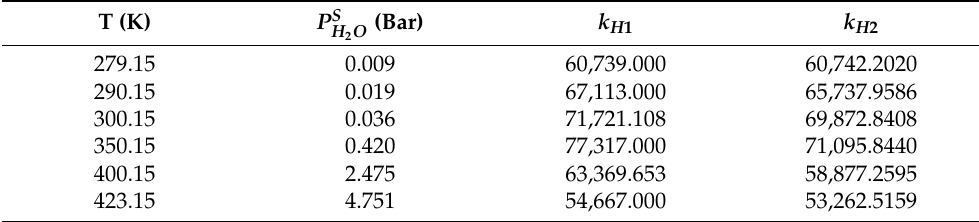
Table 9. Henry’s constant ( k H ) of H 2 in pure water ( k H 1 reported by Fernandez-Prini and Roberto [54]; k H 2 calculated using the proposed model).